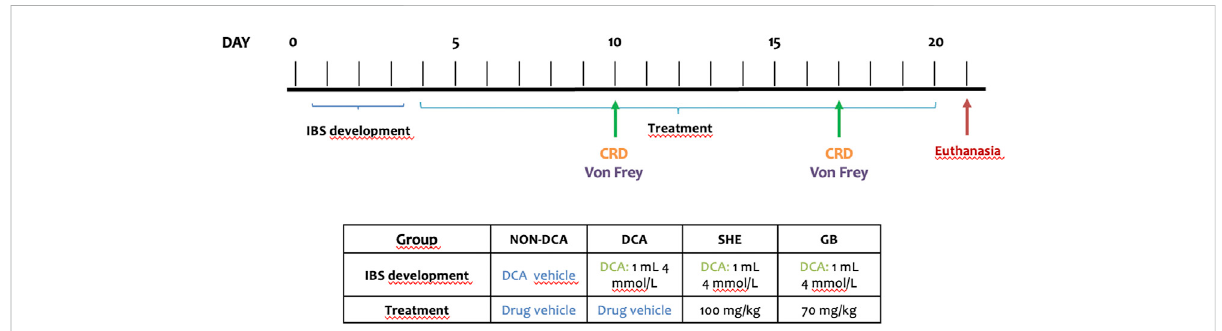
FIGURE 1 Experimental procedures. Rats were anesthetized and 1 ml of 4 mmol/L DCA was administered through the anus for three consecutive days. The drug treatments Serpylli herba extract (SHE) (100 mg/kg) or gabapentin (GB) (70 mg/kg) started the next day of the last DCA injection and continued for 17 days until rats were euthanized with an overdose of halothane.